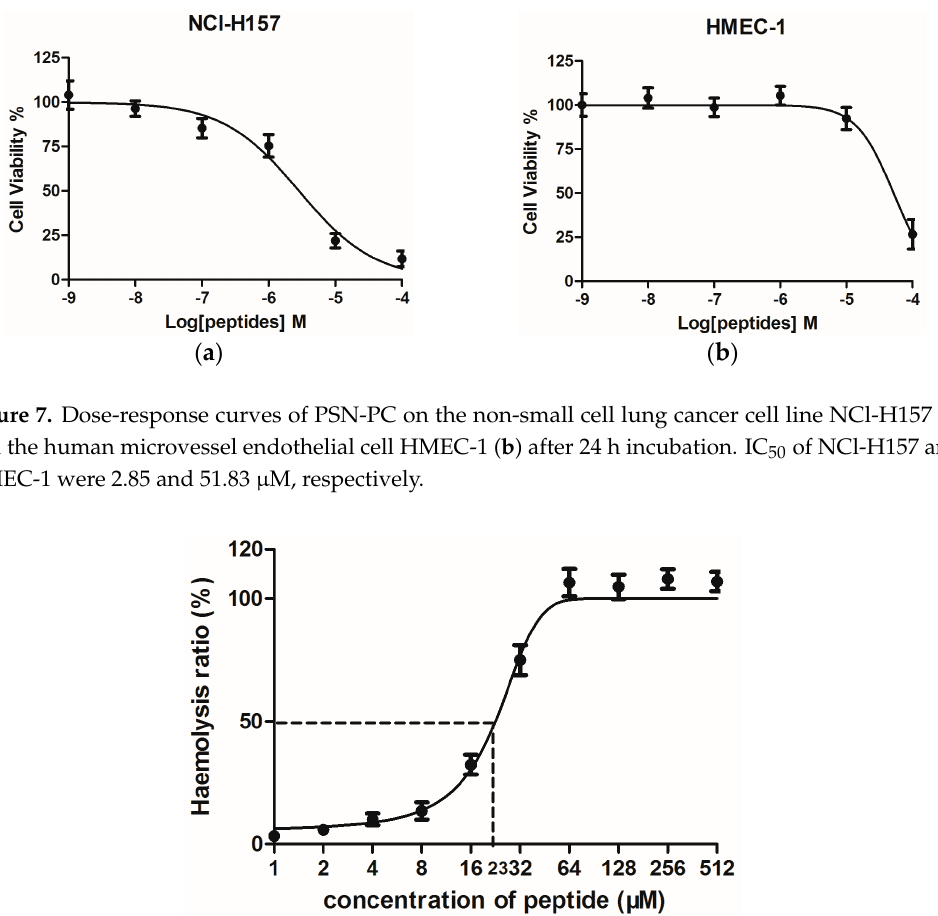
Figure 6. ( a ) Time-killing curves for PSN-PC on S. aureus . The antimicrobial peptide was added at time 0 h; ( b ) Cell-membrane permeability effects of S. aureus incubated with the peptide. The results were analysed by one-way ANOVA, followed by the Newman-Keuls test, and showed differences between 2, 4 and 8 µM ( b ) (***) p < 0.001.